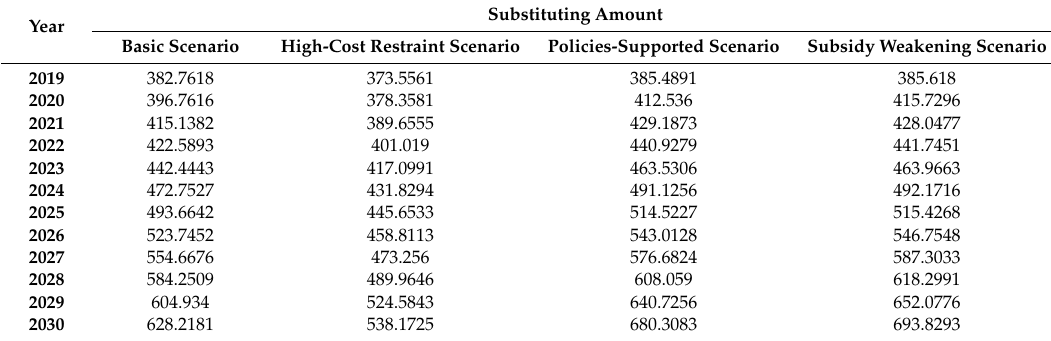
Table 7. Multi-scenarios forecasting